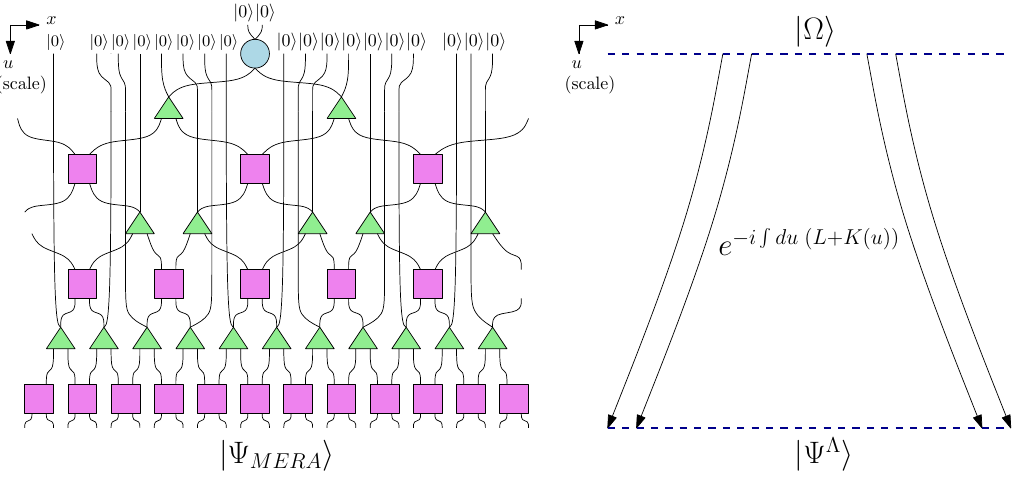
Figure 2 . Left . A MERA seen as a quantum circuit. Starting from the product state on the top, each layer of unitaries introduces entanglement at shorter and shorter distances. Right . A schematic representation of cMERA that emphasizes its similarity with